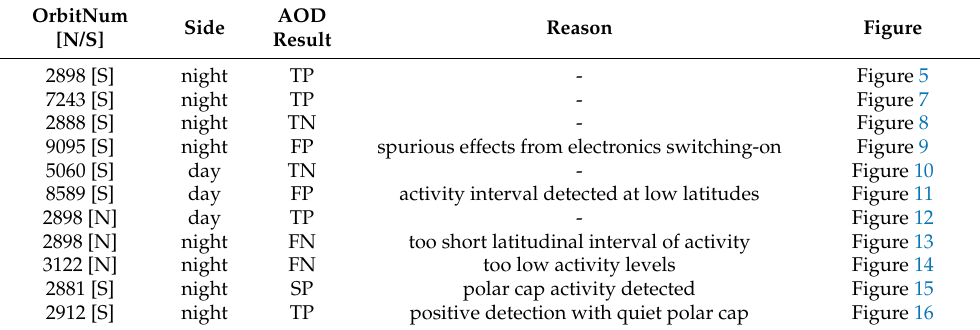
Table 2. AOD algorithm results for the validation samples analysed in this work. The table reports (from left to right) the orbit number and the hemisphere (Northern [N] and Southern [S]), the side of the ionosphere analysed, the outcome of the detection algorithm (true positive [TP] and true negative [TN] detection, false positive [FP] and false negative [FN] detection, and special positive [SP] detection), reason for wrong outcome, and the corresponding